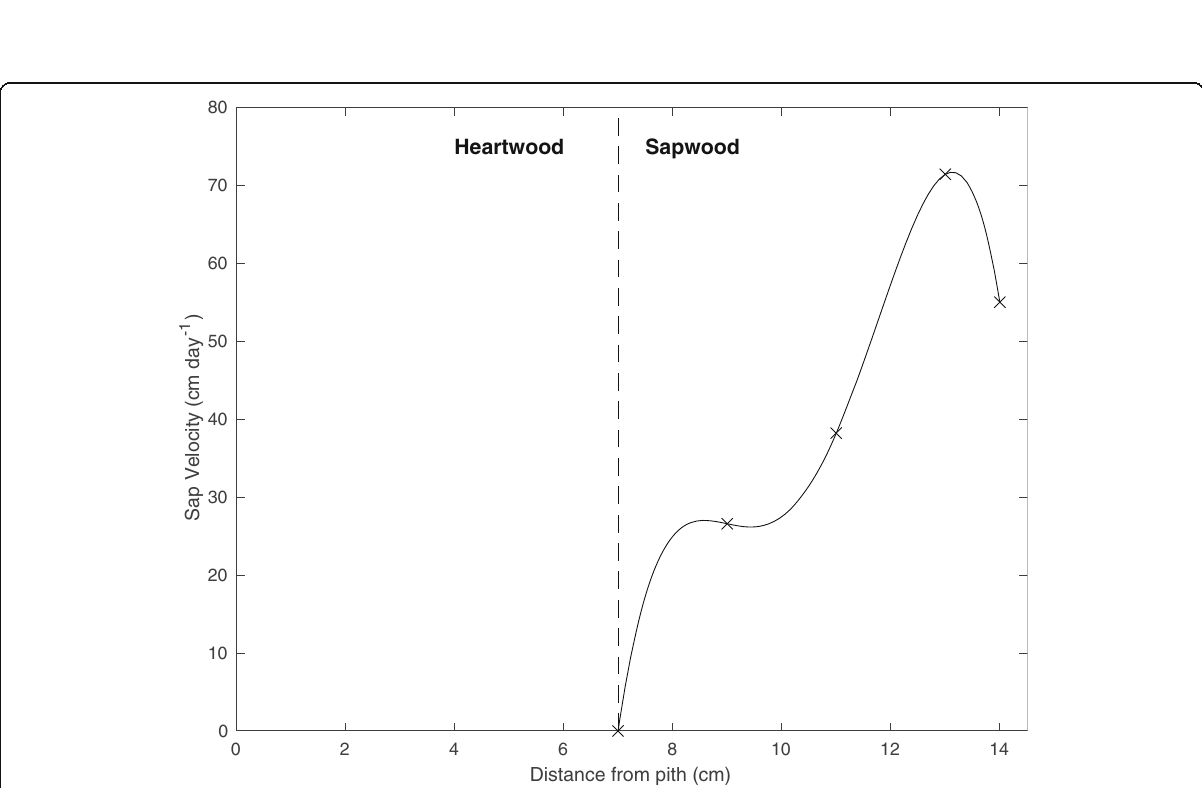
Fig. 3 Diurnal patterns of sap flux densities ( J s ) at different depth intervals within the sapwood from August 14 to 20, 2019